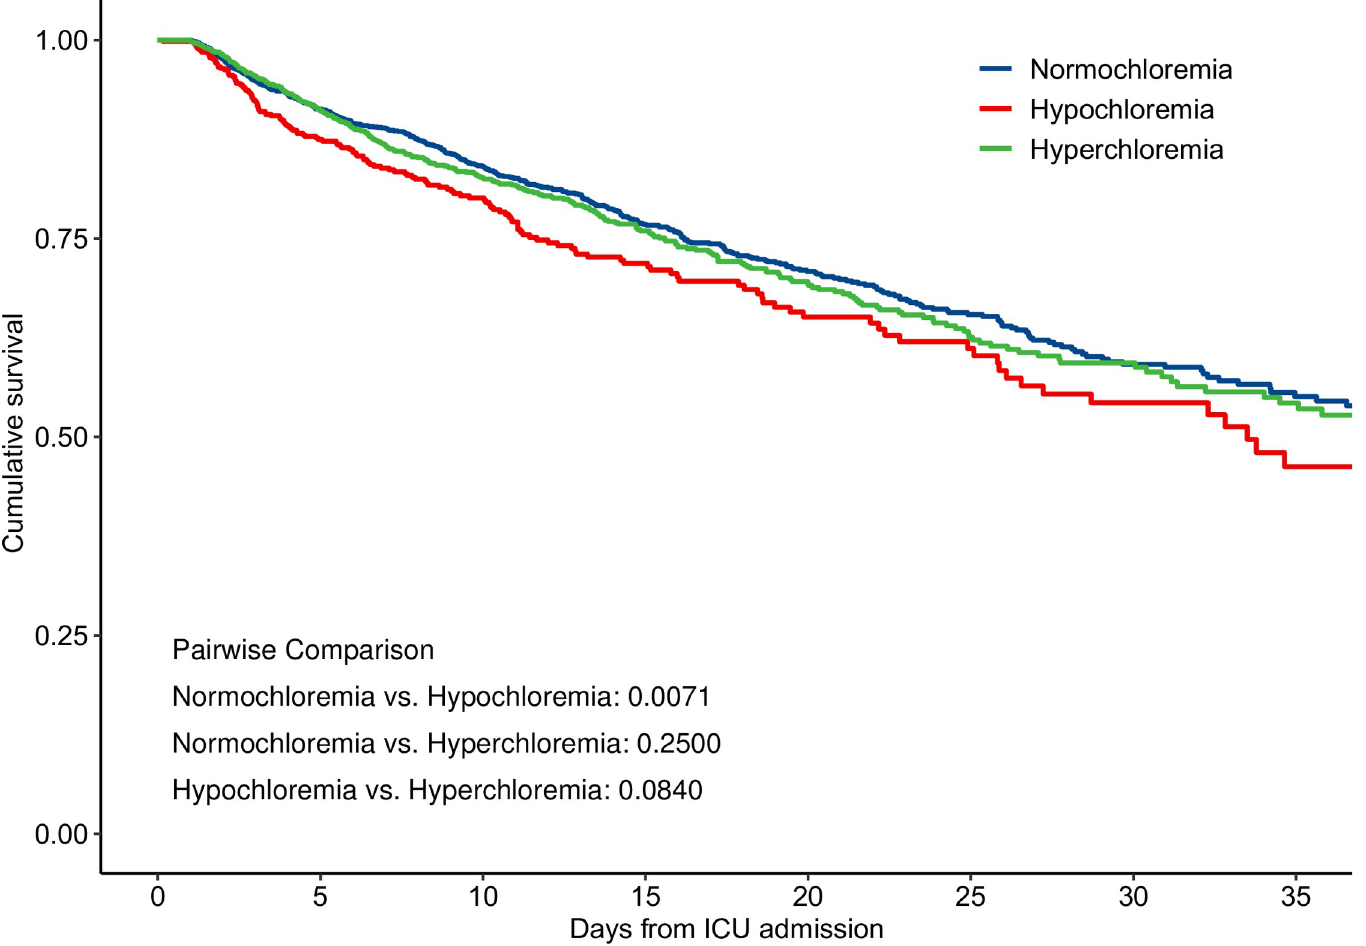
Fig 4. Kaplan-Meier survival curve for in-hospital mortality stratified by serum chloride in three groups. Log rank p-values between groups were reported.